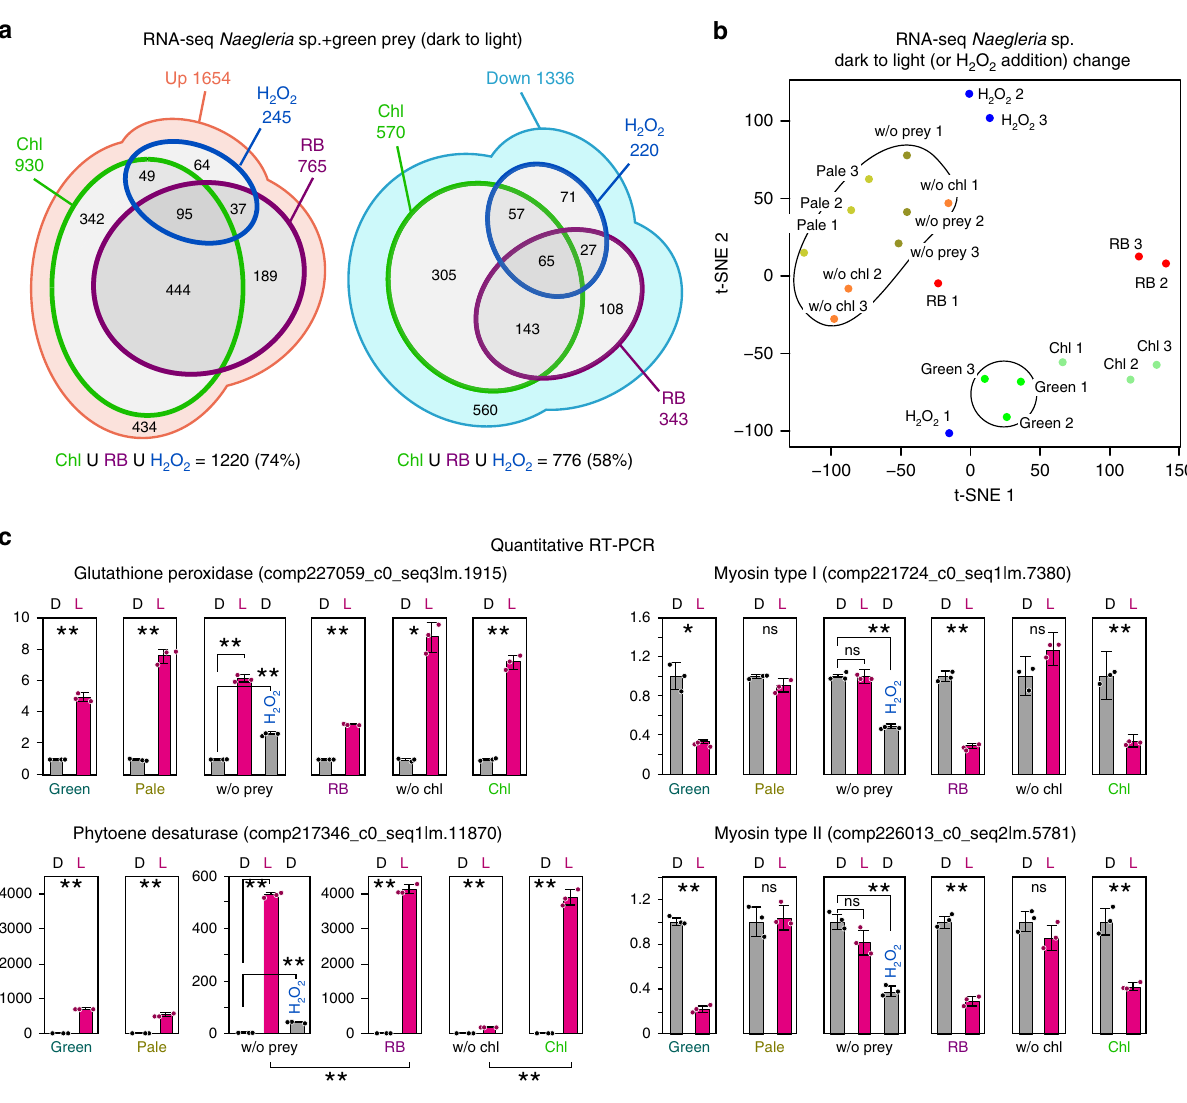
Fig. 4 Transcriptomic effect of the photosynthetic trait of bacterial prey, chlorophyll, and ROS on Naegleria sp. a The content of up-/downregulated contigs upon illumination in Naegleria sp. with green prey that were also up-/downregulated (FDR < 0.01; edgeR) in Naegleria sp. by ingestion of chlorophyll a (log2-fold change of light/dark in ‘ Chl ’ based on normalized count data by TCC package 69 , which used edgeR, was larger than that of light/dark in ‘ w/o Chl ’ ; p < 0.05, t- test; three biological replicates cultured on different days), by 30 nM Rose Bengal (RB) treatment (producing 1 O 2 in the light) [log2-fold change of light/dark based on normalized count data by TCC package in culture with RB was larger than that of light/dark in culture without RB (without prey); p < 0.05, t -test; three biological replicates cultured on different days], or by a treatment with 0.1 mM H 2 O 2 (FDR < 0.01, compared with a culture without H 2 O 2 ; three biological replicates cultured on different days). b t-SNE two dimensional representation of transcriptomic changes upon illumination (or H 2 O 2 addition in the dark) in respective culture conditions. Log2-fold changes (light vs. dark or with vs. without H 2 O 2 ) of contigs in respective culture conditions are represented. c Quantitative RT-PCR analyses showing examples of changes in mRNA levels of contigs. EF1-alpha was used as an internal control. The level under dark conditions (or before H 2 O 2 addition) was de fi ned as 1.0. The error bar represents s.d. of three replicates (three sets of RNA samples prepared from three sets of Naegleria sp. cultures that were performed at the same time). * p < 0.05; ** p < 0.005; ns, not statistically signi fi cant ( t -test). Results of other genes are shown in Supplementary Fig. 6. Examples of changes in levels (FPKM values by RNA-seq analyses) of mRNA in respective culture conditions in Naegleria sp. are shown in Supplementary Fig. 5. The details of the culture conditions are described in Supplementary Fig. 3. Source data are provided as a Source Data fi